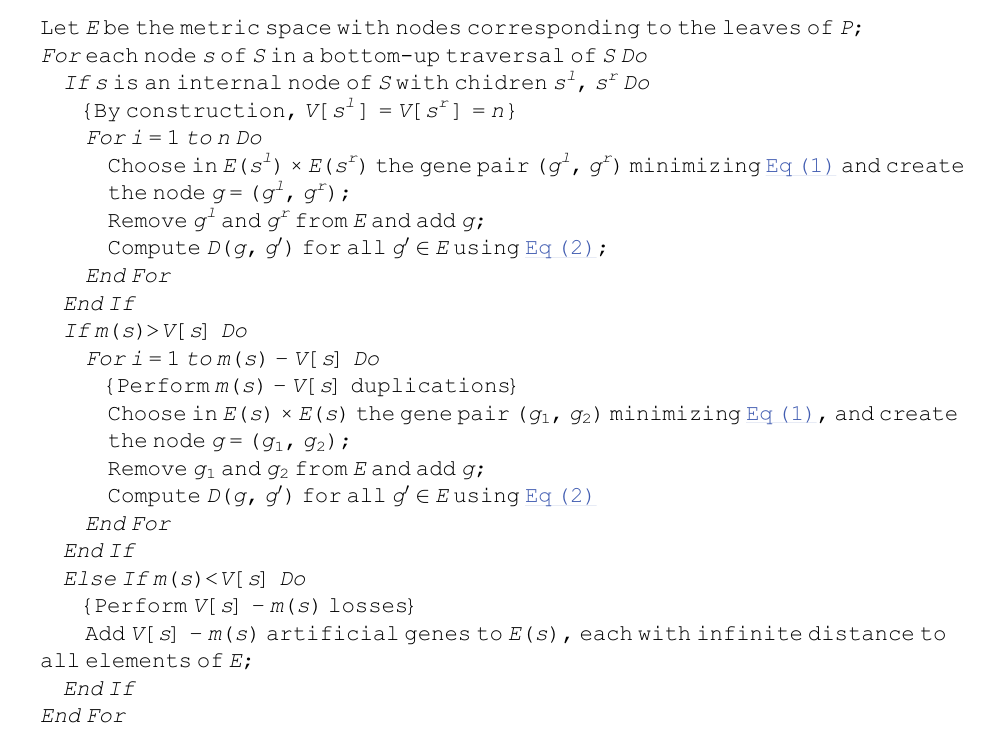
Algorithm 1 ProfileNJ